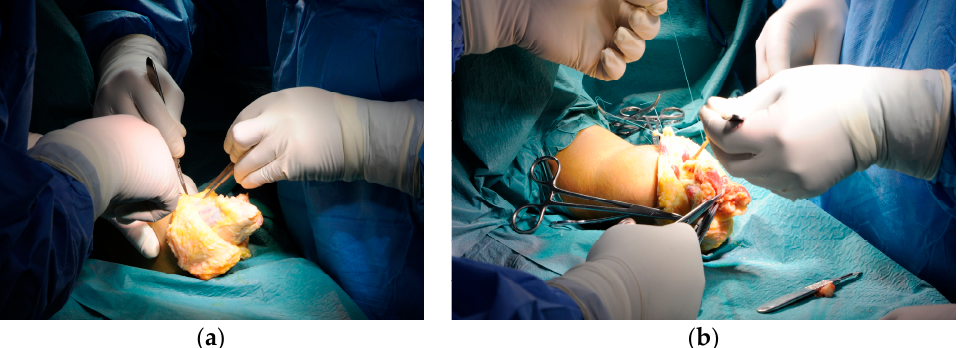
Figure 5. The CONM surgical technique with partial excision of the forearm fascia together with a reduction in the subcutaneous fat layer and re-disposition of the individual muscles.